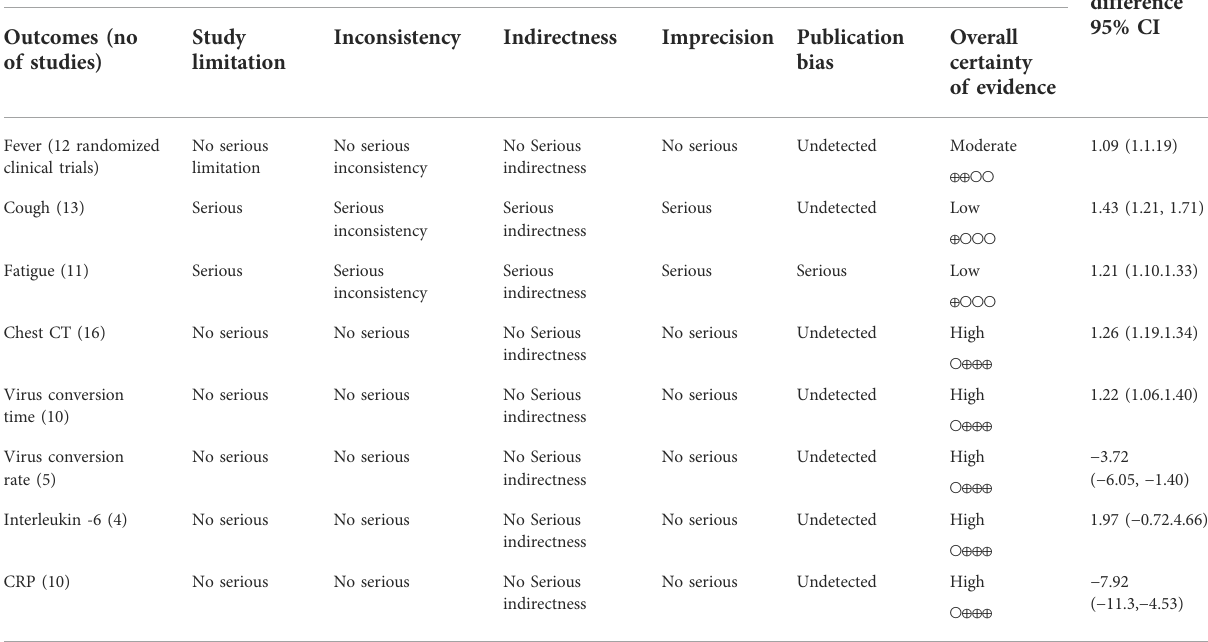
TABLE 2 Grade evidence Pro fi le. Certainty